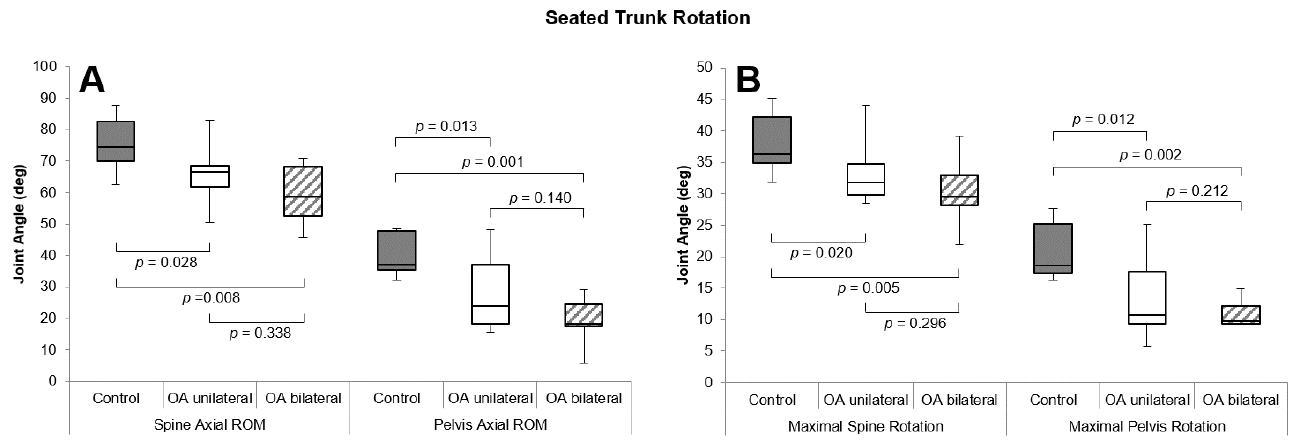
Figure 6. ( A ) Range of motion (ROM) of the axial spine and pelvis assessments during the seated trunk rotation (STR) task; ( B ) maximal axial spine and pelvis rotation assessments during the seated trunk rotation (STR) task, for the control (dark grey), unilaterally affected osteoarthritis (OA) (white), and bilateral OA (dashed) participants.